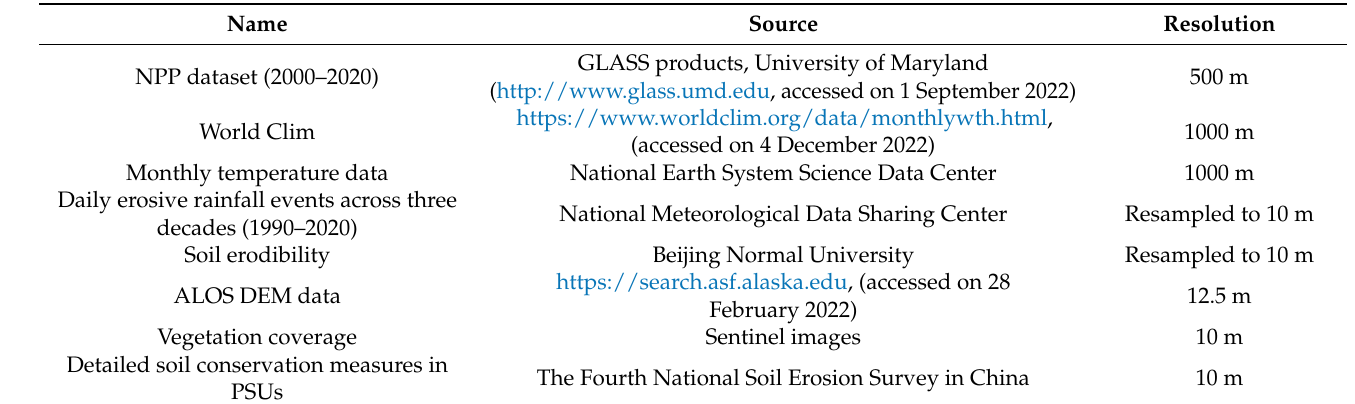
Table 2. List of the major multi-source data in this study.